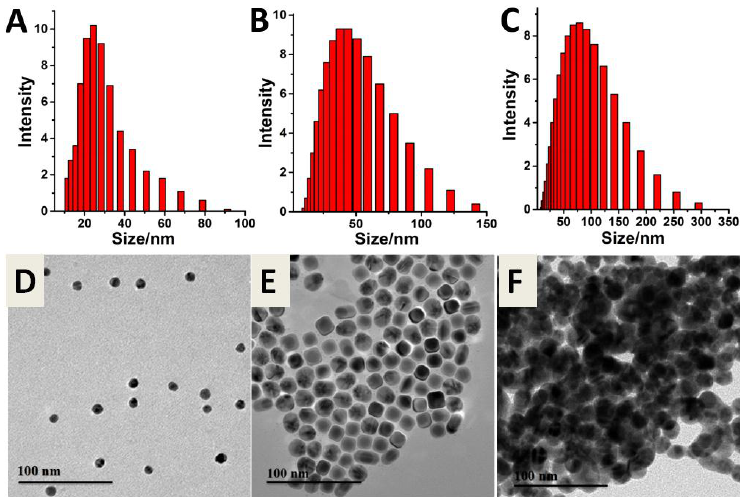
Figure 1. Mean average hydrodynamic diameters of ( A ) Au@Ag NPs, ( B ) Au@Ag NPs probes and ( C ) Au@Ag NPs probes aggregations in the presence of Pb 2+ . Transmission electron microscopy (TEM) of ( D ) Au@Ag NPs and ( E ) Au@Ag NPs probes and ( F ) Au@Ag NPs probes aggregations in the presence of Pb 2+